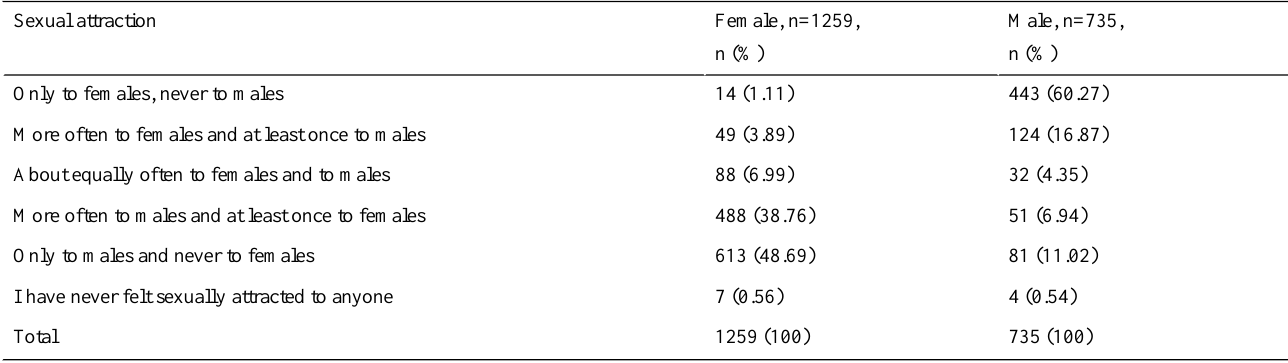
Table 3. Sexual attraction (by gender, male or